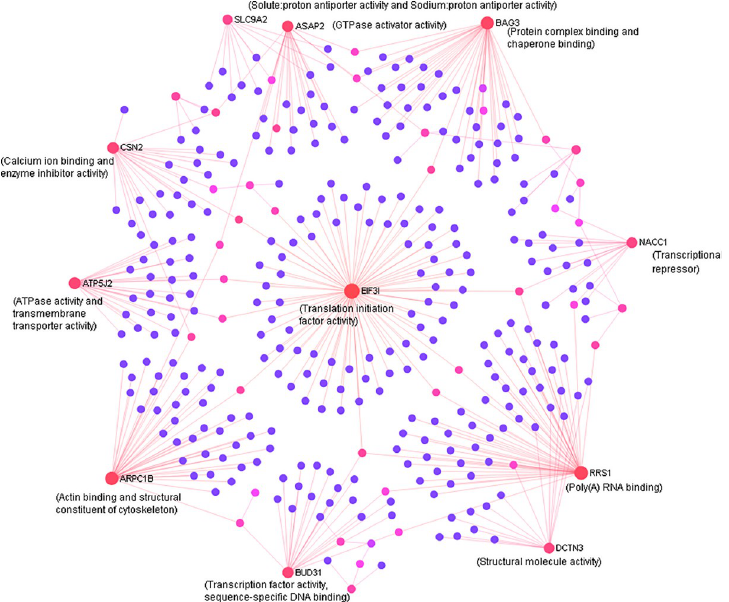
Fig 4. Network of commonly altered genes after PRRSV vaccination both in DL and Pi pigs. The interconnecting network showing the potential hub genes of the functional network of DEGs commonly observed in PBMCs of both DL and Pi pig at 24 h after PRRSV vaccination. Each circle of the network indicates node (seed gene) and the diameter of node accounted for its centrality estimates. Lines between nodes indicate the connectivity. The GO for corresponding genes are provided within the parenthesis. The network centrality estimates and relative expression values of major hub genes are provided in Table 1.